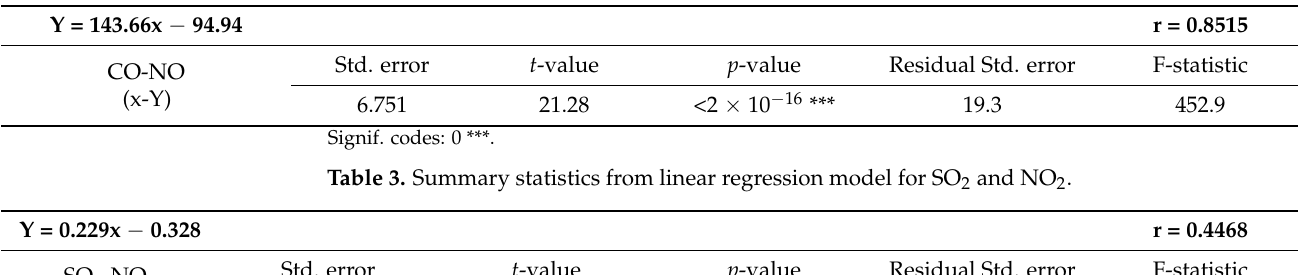
Table 2. Summary statistics from linear regression model for CO and NO.